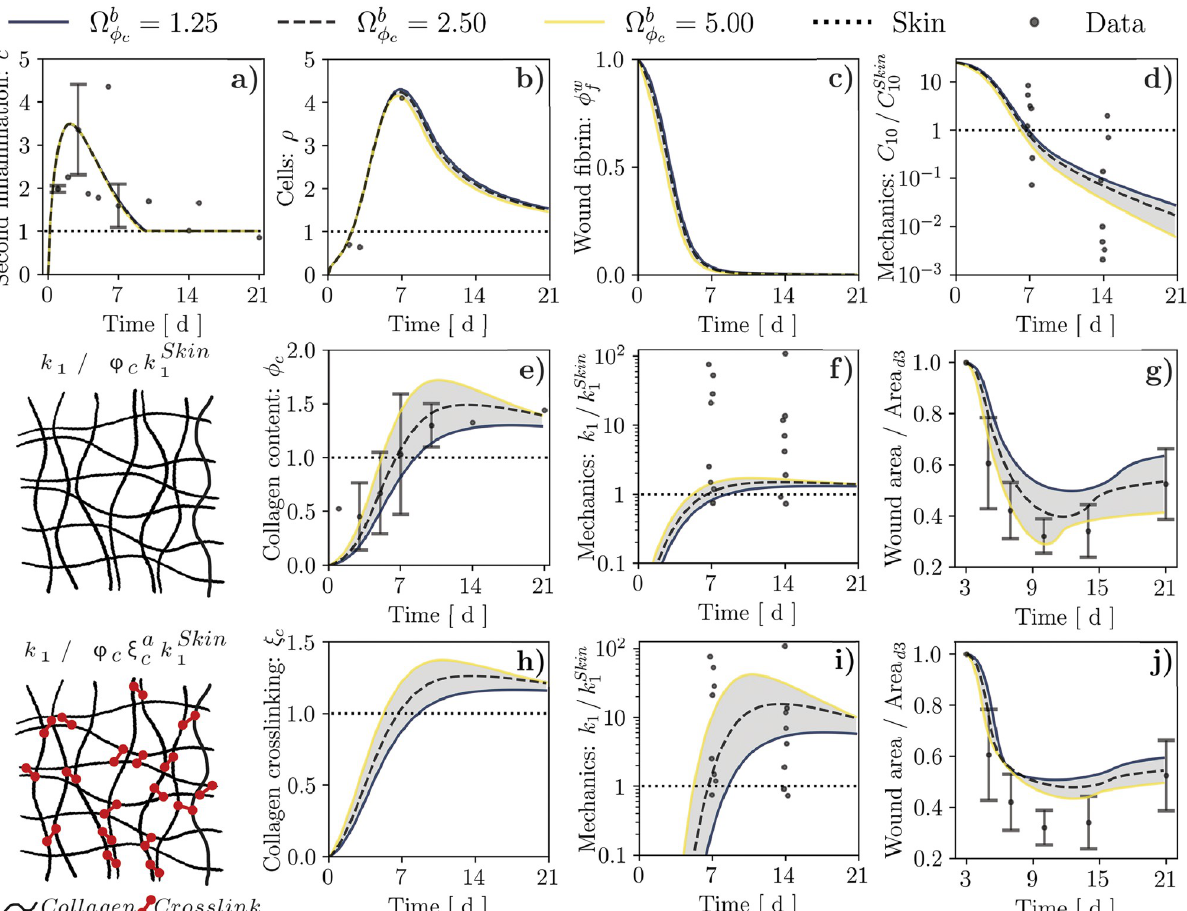
Fig 6. Results of wound healing simulation over a 21-day period for alternative links between the tissue collagen content, ϕ parameter k 1 , and alternative values of the parameter O b that controls collagen production by cells. ( a – d ) Temporal evolution of second � c inflammatory signal, c , cell population, ρ , wound fibrin content, � w , and mechanical parameter C f quantities do not depend explicitly on ϕ , hence we report them only once. ( e – g ) Temporal evolution of tissue collagen content, ϕ c parameter k = k Skin , and wound area change resulting from assuming that k 1 is proportional to ϕ c . ( h – j ) Temporal evolution of collagen crosslinking, ξ c , 1 1 mechanical parameter k = k Skin , and wound area change resulting from assuming that k 1 depends nonlinearly on ϕ c via ξ c . Dots and error bars in ( a , b , e , g , 1 1 j ): mean ± standard deviation of previously-published experimental data, cf. S1 Appendix and Ref. [10]. Dots in ( d , f , i ):values of C obtained from Bayesian calibration, cf. Fig